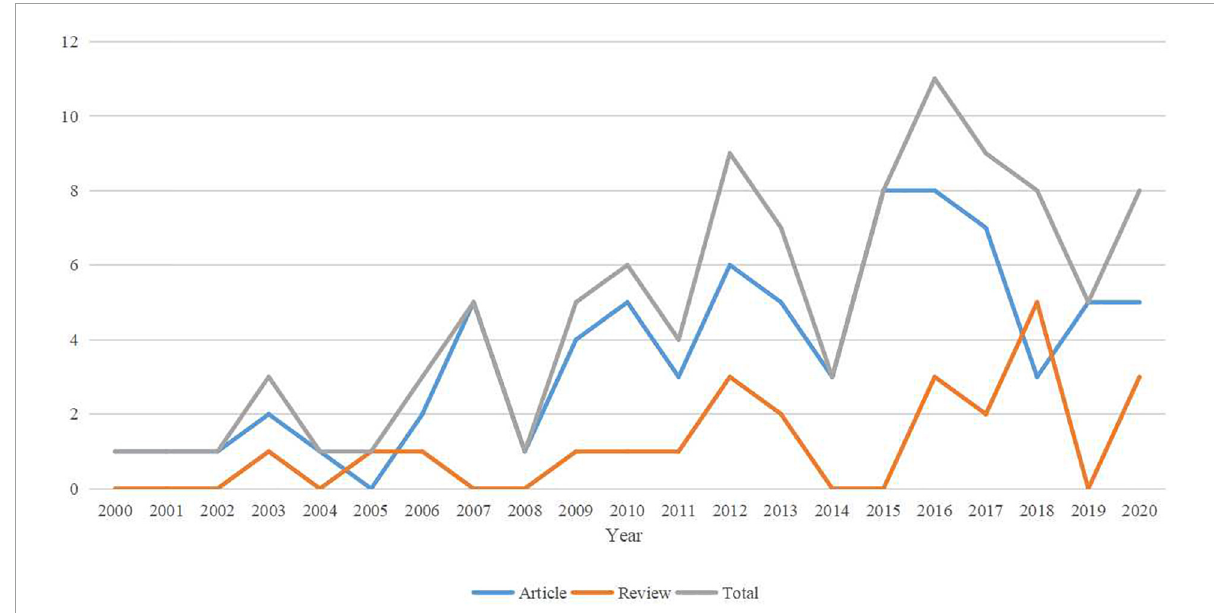
FIGURE2 The number of publications among different types of papers according to publication year.